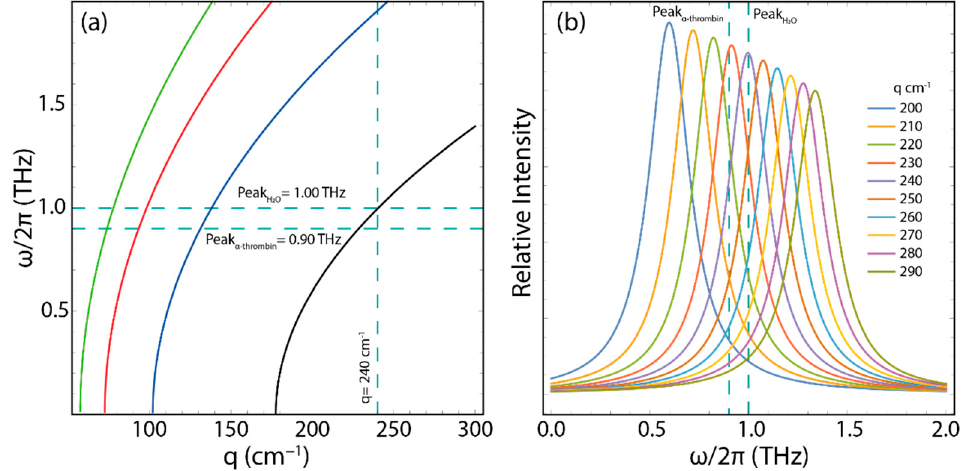
Figure 17. ( a ) Plasmon frequency dispersion ( ≤ 2 THz) ( ω /2 π ) vs. wave vector ( q ), considering different ribbons widths (155, 270, 380, and 480 nm). ( b ) Plasmon excitation lifetime for w = 155 nm, considering different momenta from 200 to 290 cm − 1 . The parameters of Equation (4) have been fixed as: N 2 D = 1.0 × 10 12 cm − 2 , θ = 0, and ν = 2.24 × 10 13 s − 1 . The plasmon spectra were calculated using the Lorentzian shape function to a maximum value of 1 with FWHM =